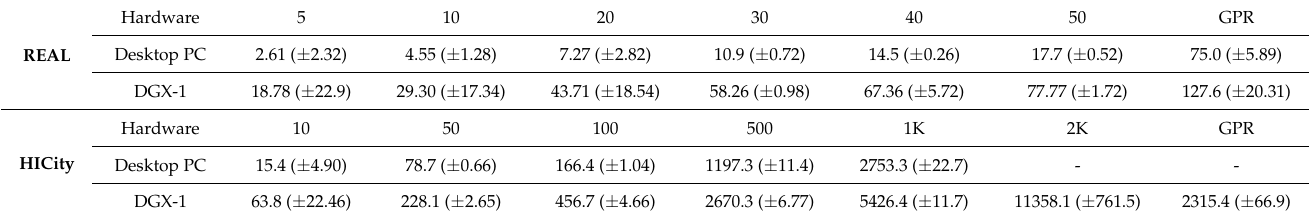
Table 5. Result of time when generating magnetic map (data: mean ( ± 2 × std )(s)). All the results are calculated as the mean and standard deviation of the 10 experimental results.As for the magnetic mapping in HICity, the time could not be measured in the case of GPR and 2K inducing variable points due to the forced termination of the program by insufficient